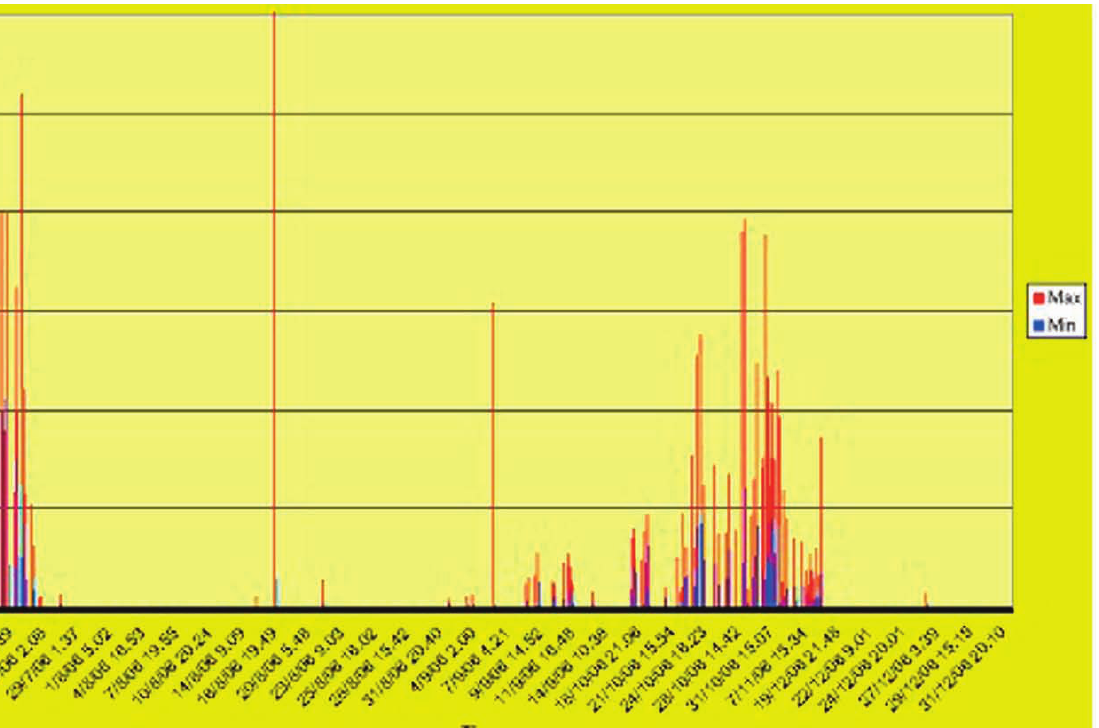
Figure 13 (left). Pie chart statistics for (A) detection, (B) cloudiness, and (C) sauration for the hot-spots analyzed from the AVHRR data for the Mount Etna eruption from June to December, 2006. Figure 14 (below). AVHRR-derived maximum (red) and minimum (blue) effusion rates for the 2006 Mount Etna